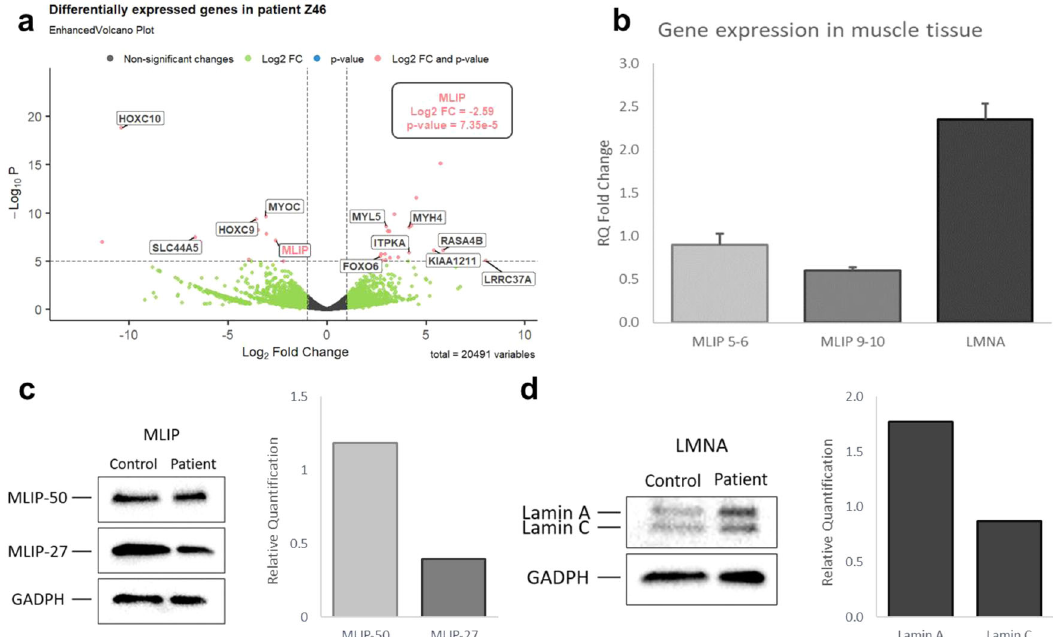
Fig. 1 MLIP and LMNA respective expression in muscular tissue. a Volcano Plot highlighting the most differentially expressed genes in Z46 compared to controls following DESeq analysis. b RT-qPCR reveals mRNA expression levels for the targeted genes: MLIP 5 – 6 accounts speci fi cally for transcripts containing the nonsense mutation, MLIP 9 – 10 covers all the known transcripts, and LMNA probe accounts for both lamin A and C. RPS29 is used for data normalization, error bars correspond to standard deviation (triplicata). c, d Western Blot analysis reveals the presence of four isoforms of MLIP, two of which can be quanti fi ed (27 kDa and 50 kDa). Both lamin types also appear for LMNA and were analyzed separately. GAPDH is used as the reference gene for normalization of the blot in both